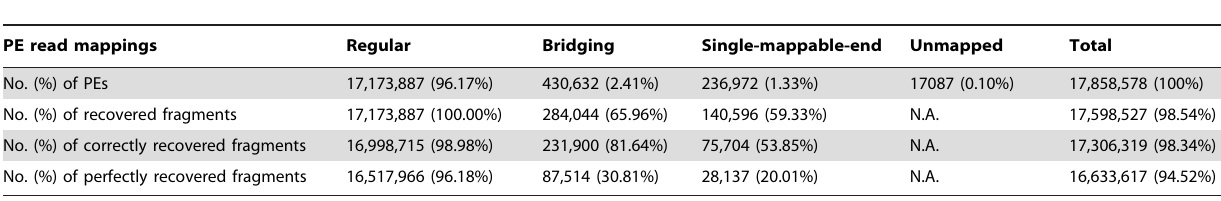
Table 10. ARF-PE statistics on three types of simulated data of human chromosome 22.